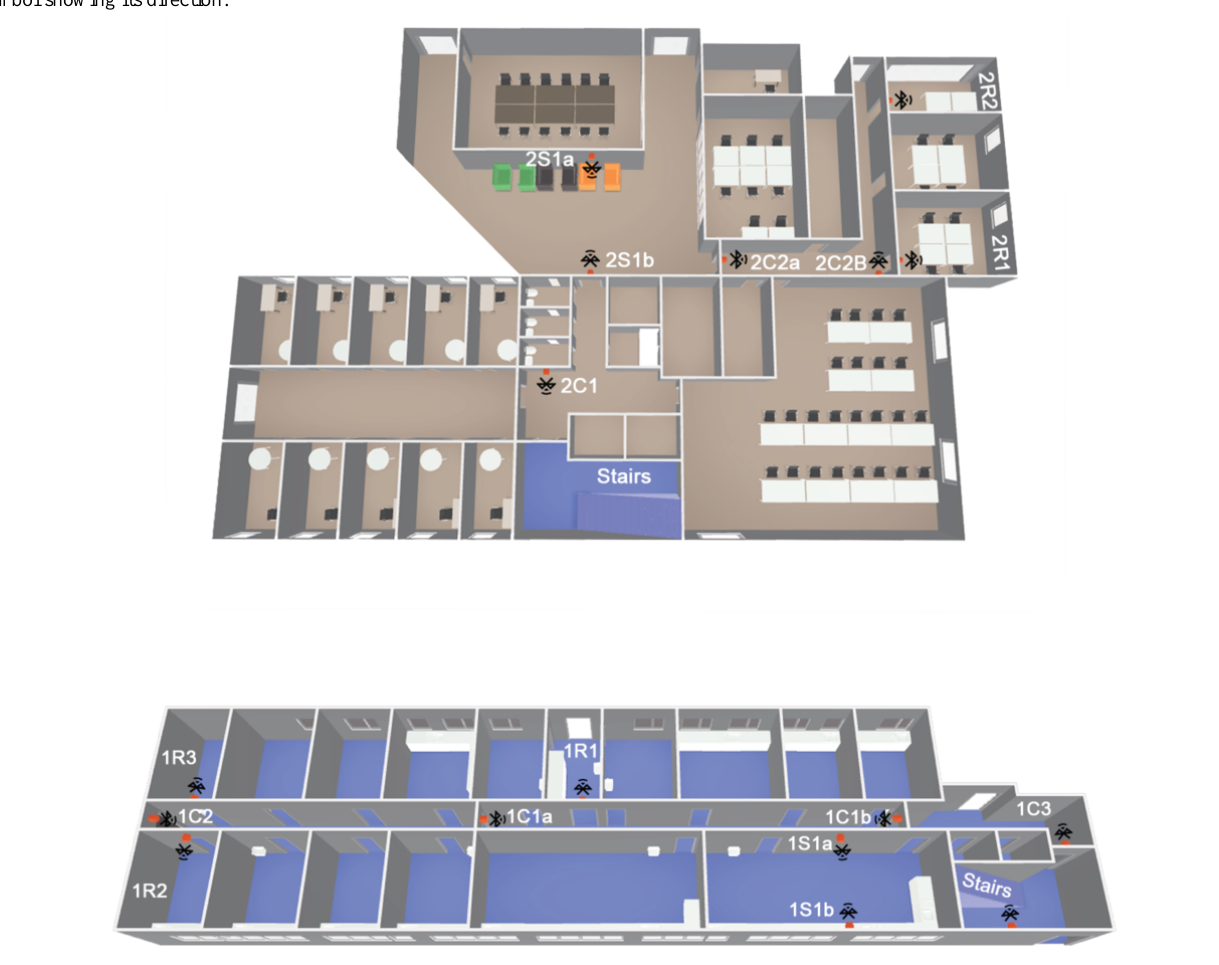
Figure 2. Building floorplan and beacon positions: Top: First floor; Bottom: Ground floor. Each beacon is shown in red with an accompanying Bluetooth symbol showing its